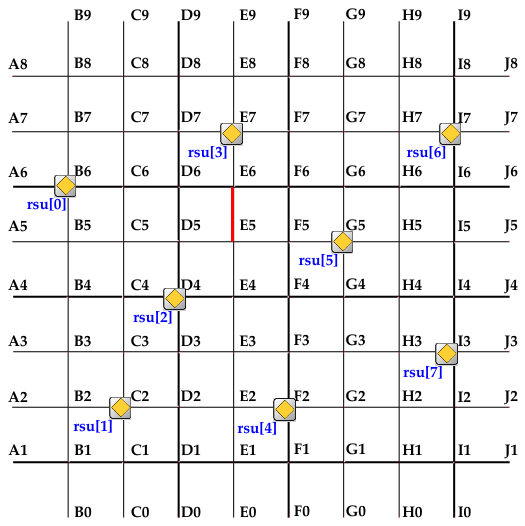
Figure 19. Road network in Simulation of Urban Mobility (SUMO).